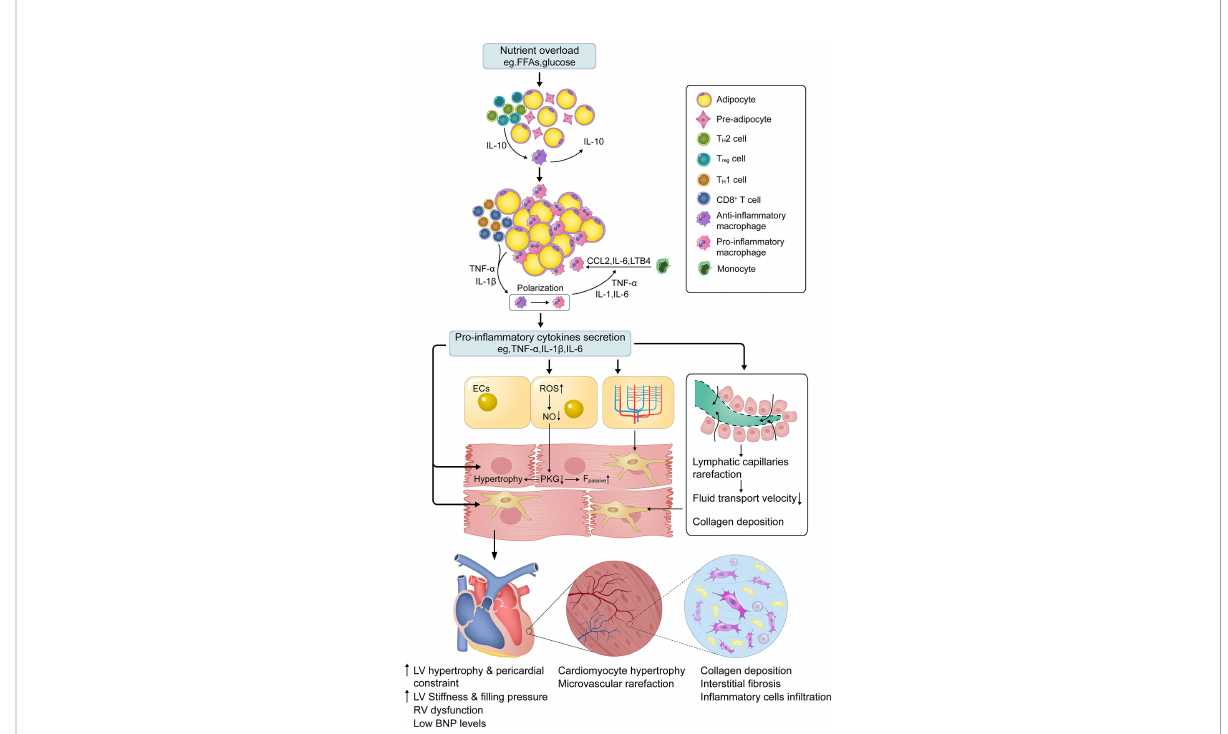
FIGURE 1 Central role of low-grade systemic in fl ammation in obese HFpEF. In normal adipose tissue, T H 2 and T reg polarized T cells predominate in ATTs. These T cells secrete IL-10, which stimulates resident ATMs to secrete IL-10 to limit in fl ammation. Chronic nutrient overload induces adipose tissue expansion and a shift in ATTs such that CD8 + and T H 1 polarized T cells dominate, which recruit circulating monocytes to adipose tissue through chemokines (e.g., CCL2). Under the stimulation of cytokines (e.g., TNF- a and IL-1 b ) secreted by ATTs and enlarged adipocytes, ATMs polarize towards a pro-in fl ammatory macrophage phenotype and attract additional monocytes by secreting pro-in fl ammatory cytokines (e.g., IL-6, IL-1, and TNF- a ). This forms a vicious cycle in which adipose tissue becomes in fl amed. High levels of circulating proin fl ammatory cytokines activate in fl ammatory cascades in different cardiac cells, which are associated with cellular dysfunction. Among them, coronary microvascular endothelial ROS overproduction and dysfunction drive cardiomyocyte hypertrophy and stiffening, as well as interstitial fi brosis, by lowering myocardial NO bioavailability and PKG activity, which is the critical mechanism for obese HFpEF. Microvascular and lymphatic capillary rarefaction also contributes to interstitial fi brosis through insuf fi cient cardiac perfusion and poor lymphatic transport. FFAs — free fatty acids;